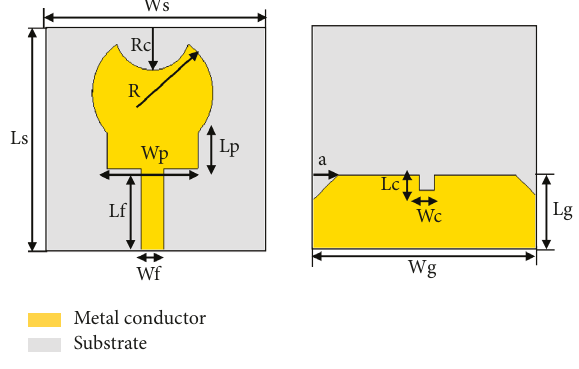
Figure 1: Layout of the reported Table 1: Optimized values of reported design (mm).